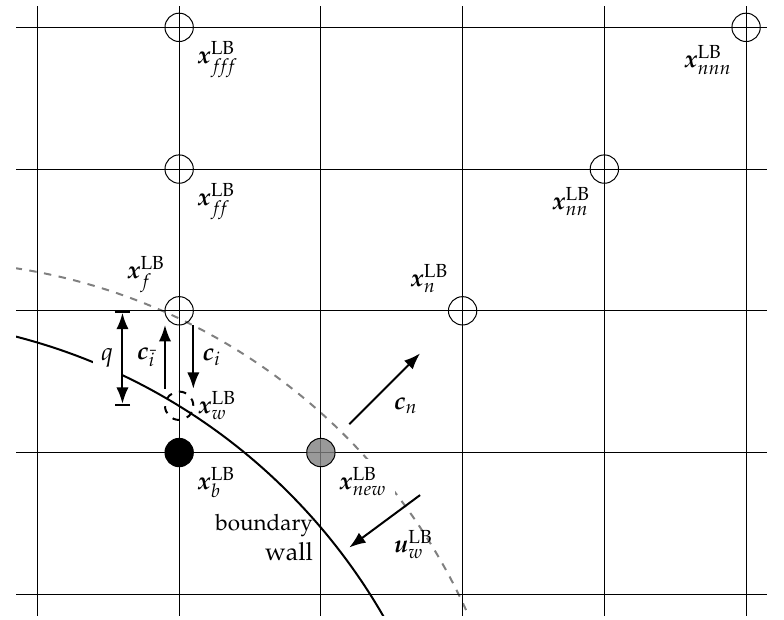
Figure 1. Illustration of the used indexing convention. The index b is related to the boundary node positioned inside the solid domain. In direction c i the wall is intersected at x LB . The locations x LB , x ff , and x fff denote the w f corresponding fluid nodes in this direction. The distance between x w and x f is given by the normalized distance q , which is calculated by